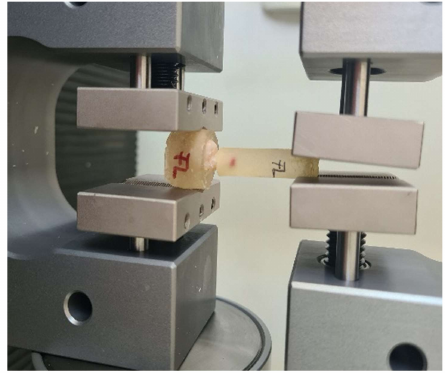
Figure 1. Pull-out mechanical test using LLOYD LR5k